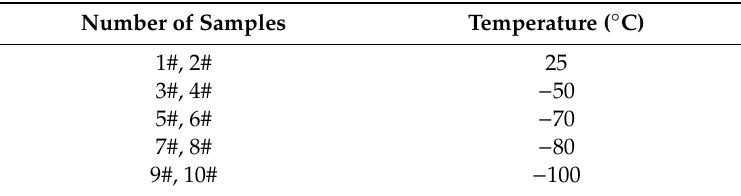
Table 1. Test temperature and corresponding samples.